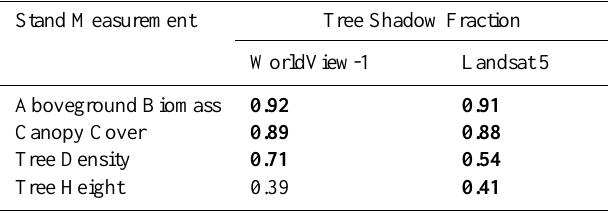
Table 2. Pearson’s correlations among field measurements of forest structure and tree shadow fraction mapped from WorldView-1 ( n = 22) and Landsat 5 ( n = 25). Correlation coefficients ( r ) in bold are significant at α < 0.05.